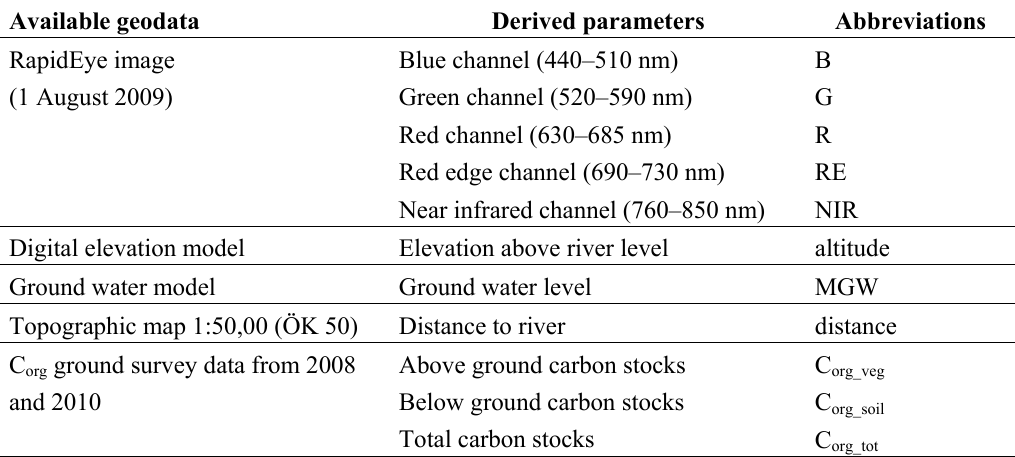
Table 1. Available geodata and derived